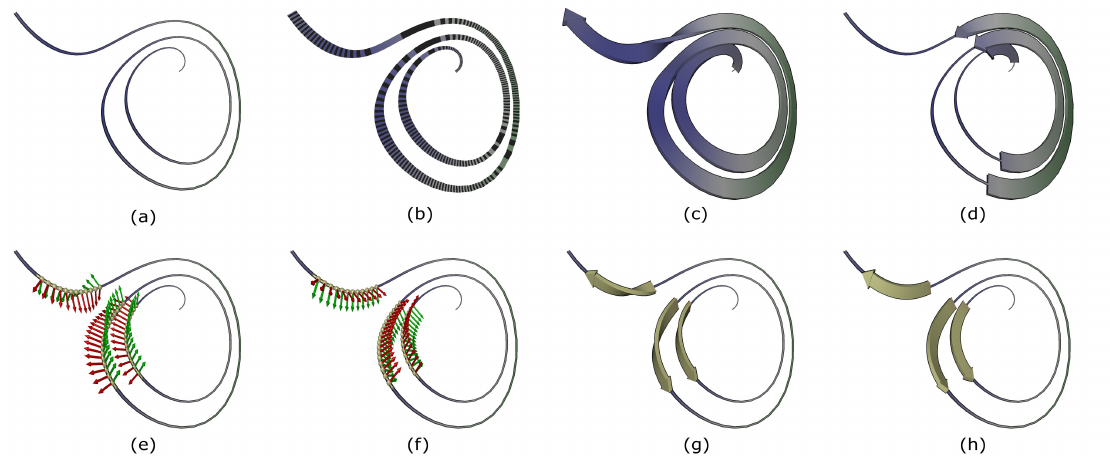
Figure 9. Top row illustrates various single trajectory representations on a synthetic data. Velocity is color mapped. Bottom row represents ribbon representation, which uses desired curvature range for placement of arrows and co-ordinate frame correction